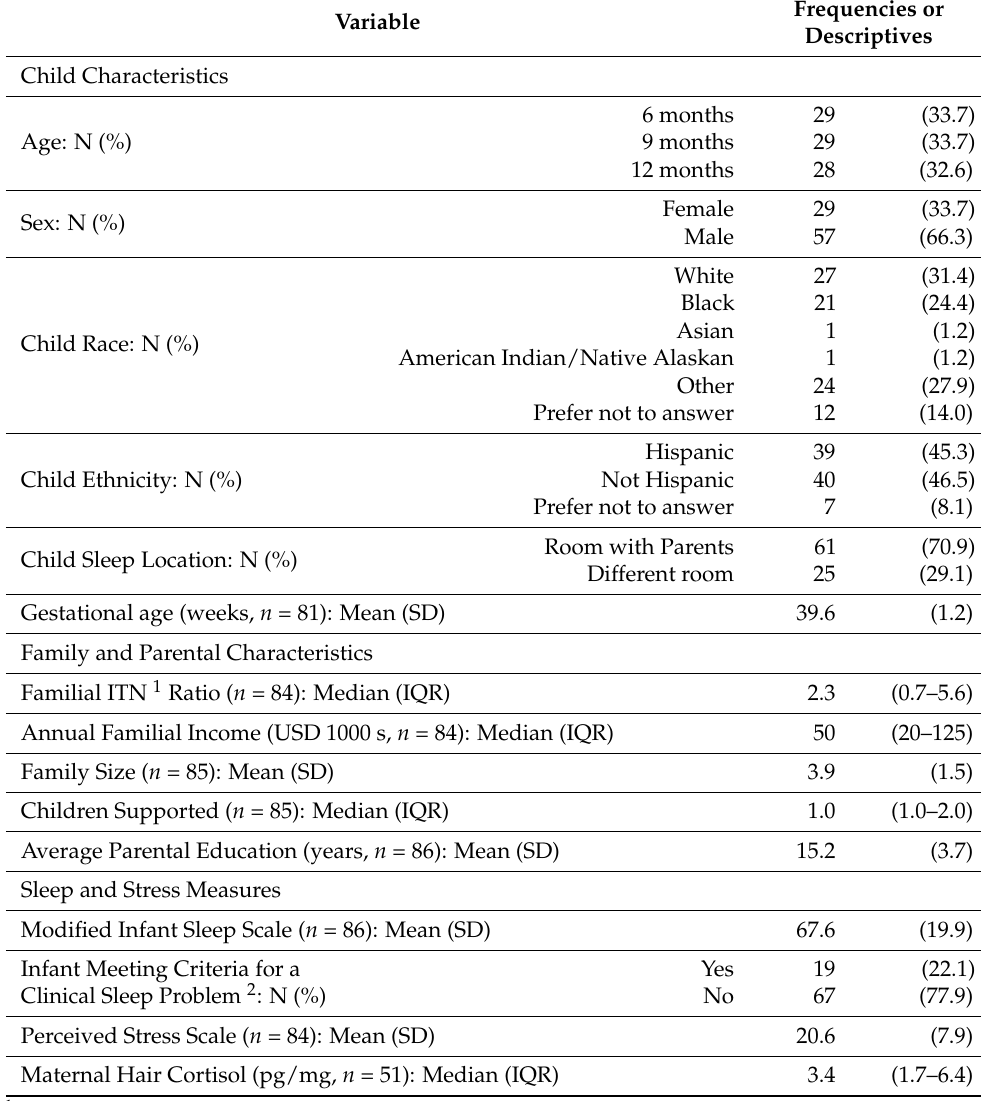
Table 1. Demographic Characteristics of study sample ( n =